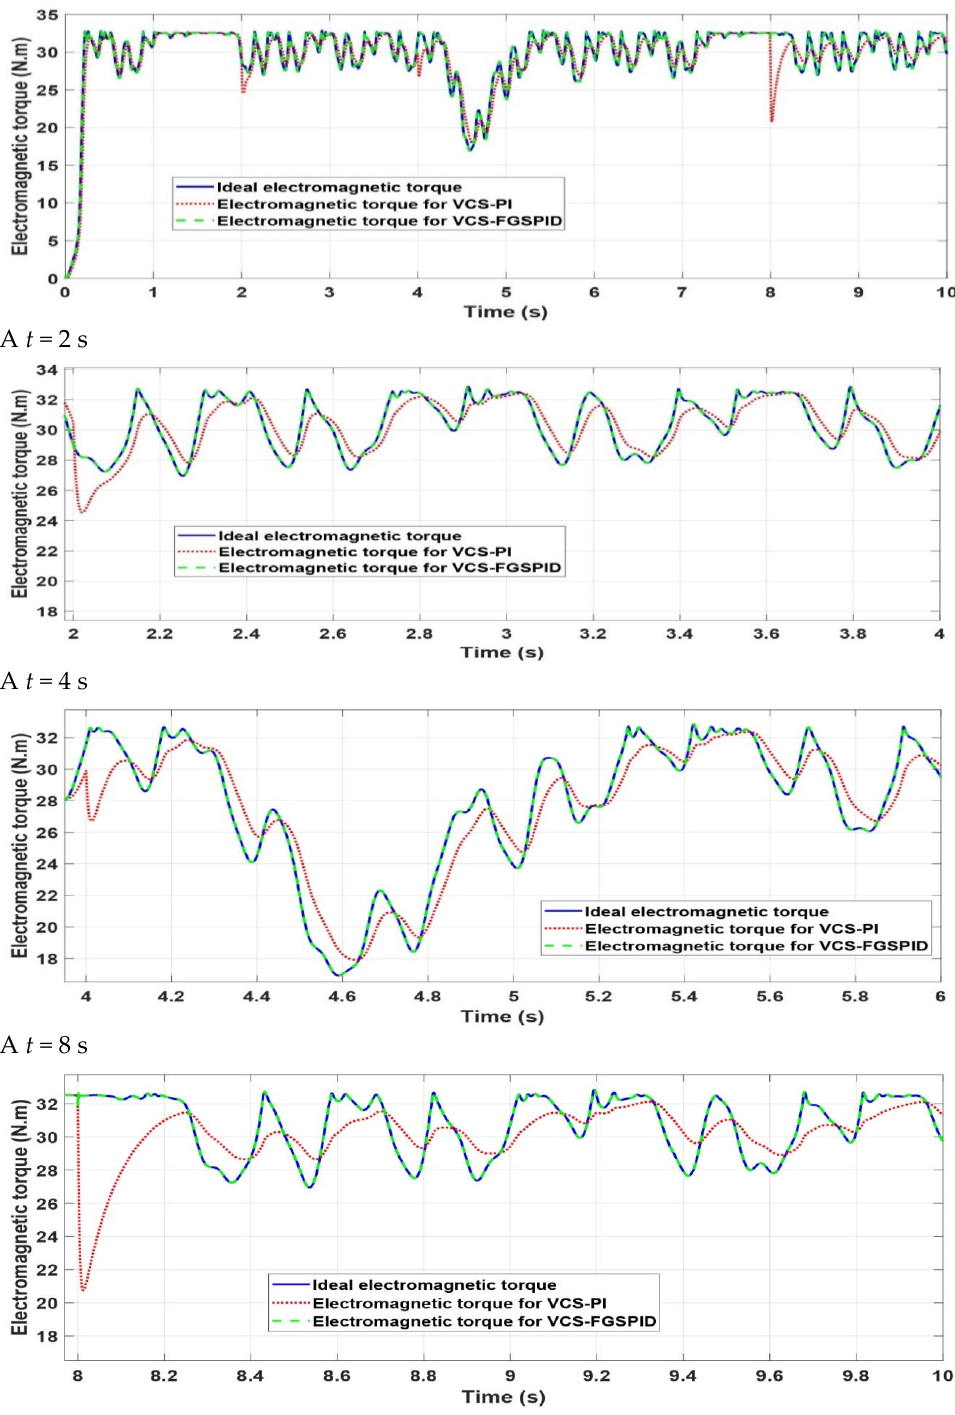
Figure 30. Electromagnetic torque response under parameter variations.